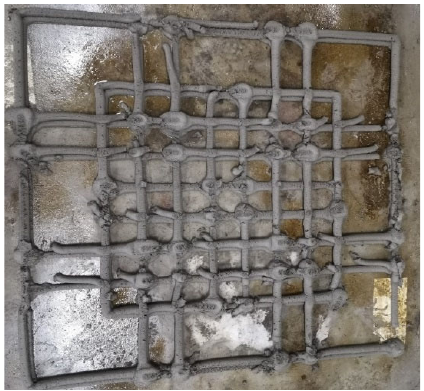
Figure 10. Concrete component printed by offset contour scanning algorithm.